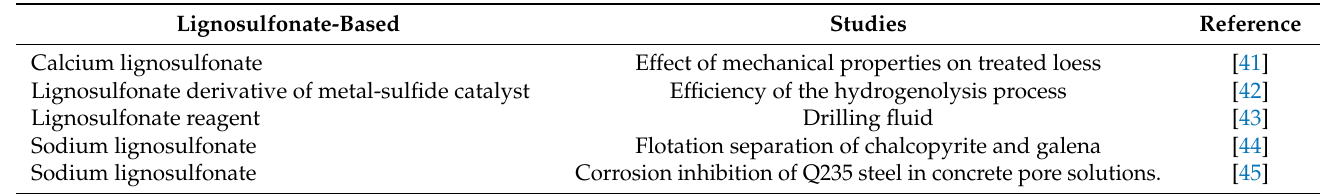
Table 2. Application of